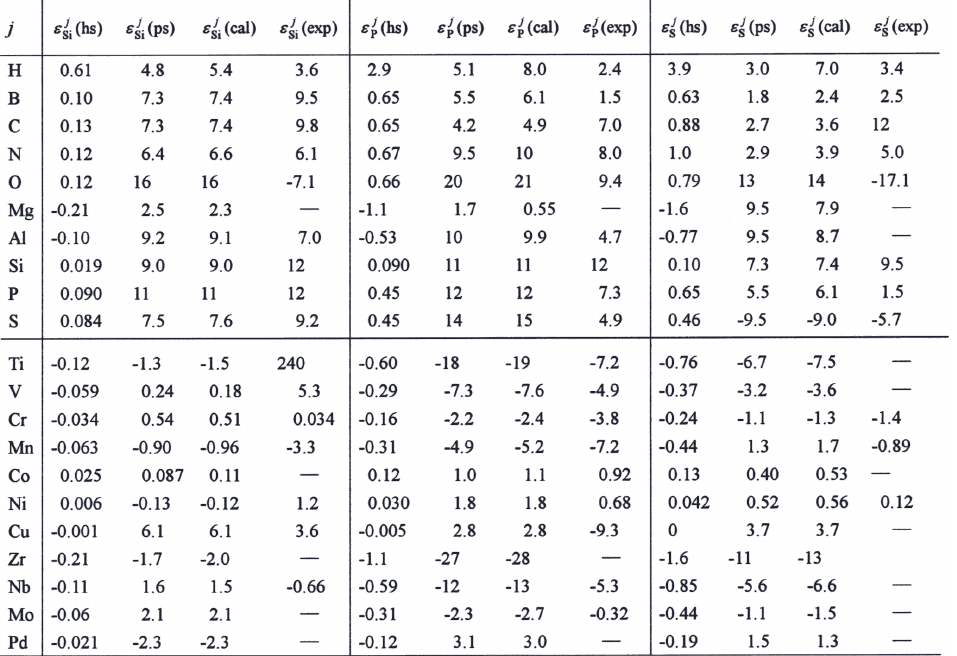
Table 3. Interaction parameters for silicon, phosphorus and sulfur in iron solutions with available experimental data at